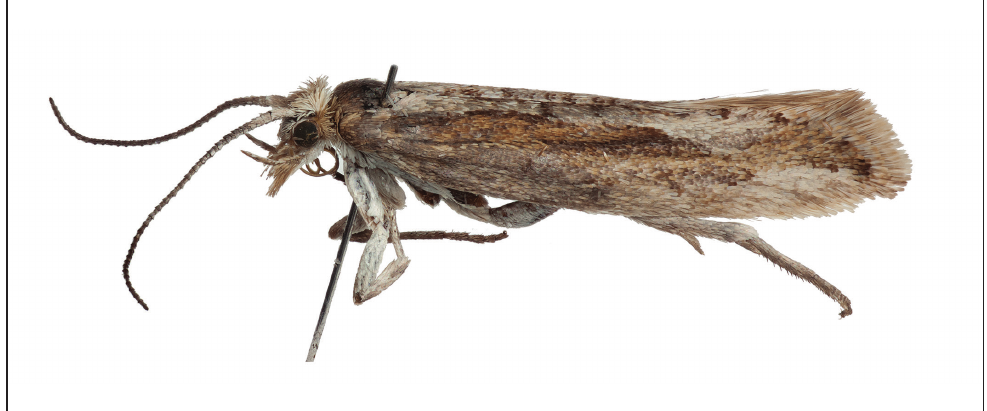
Figure 1. Plutella polaris Zeller, 1880. The single female recorded from Wijdefjorden, Svalbard in July 2015 (Photo: Karsten Sund, NHMO).